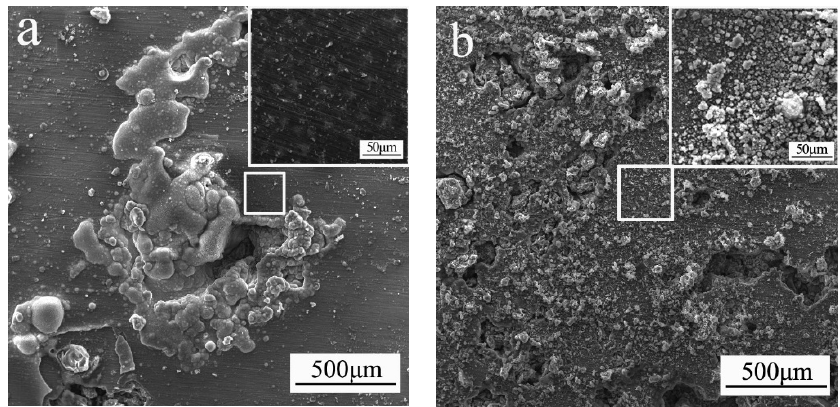
Figure 10. Morphology of corrosion products of the ultrasonic-treated ( a ) AZ91 alloy and ( b ) AZ91– 1.5Sm alloy after immersion in aqueous 3.5 wt % NaCl solution for 24 h.